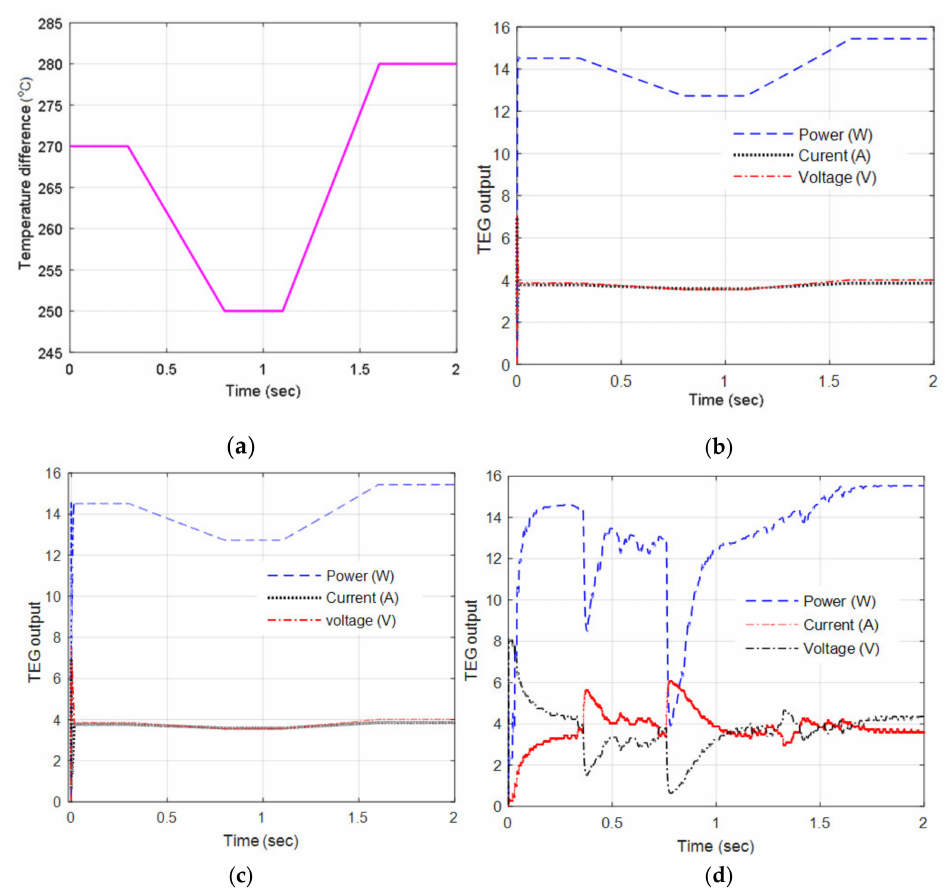
Figure 15. TEG performance for the change in temperature di ff erence; ( a ) temperature di ff erence applied attheinput; ( b )VFOFLC-basedMPPT;( c )Perturbandobserve(P&O)-basedMPPT;( d